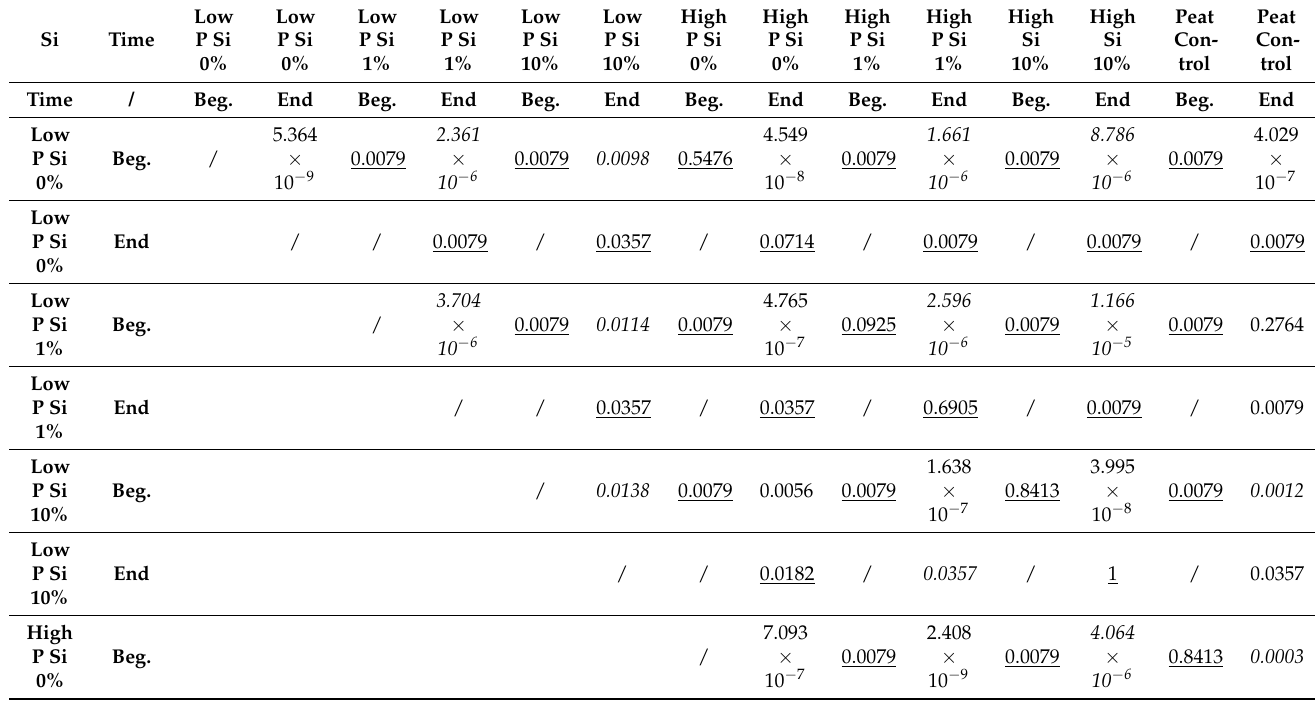
Table A4. Tables of p -values belonging to Figure